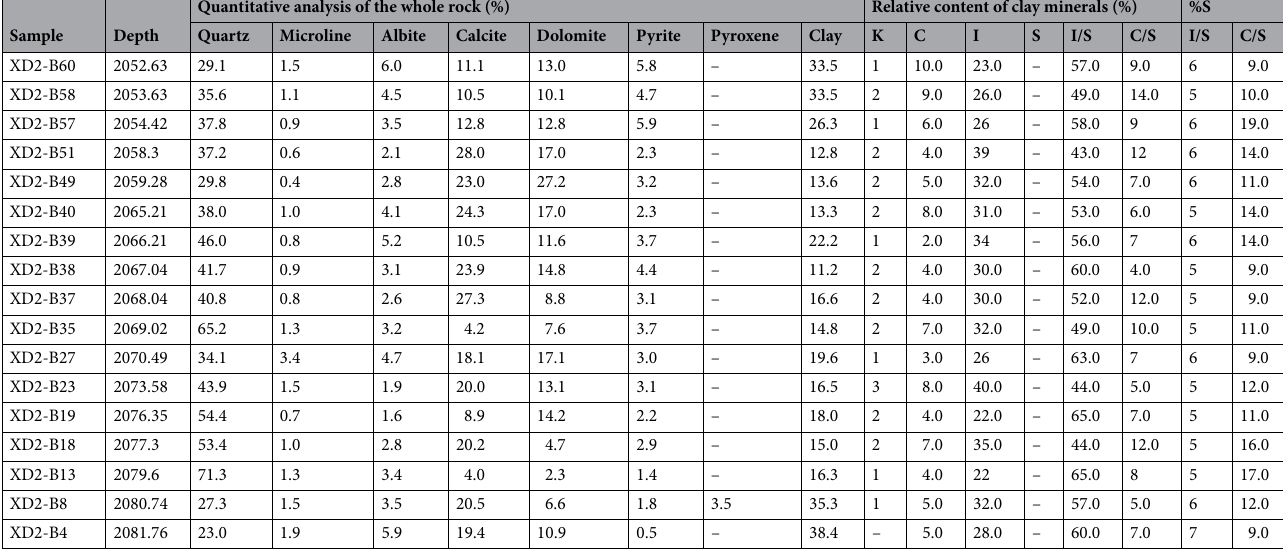
Table 1. Mineral compositions of the shales and carbonaceous marls from the Wufeng-Longmaxi formations in the Xindi No. 2 well (XRD). K kaolinite, C clinochlore, I illite, S smectite, I/S illite/smectite mixed layer, C/S clinochlore/smectite mixed layer, %S mixed-layer